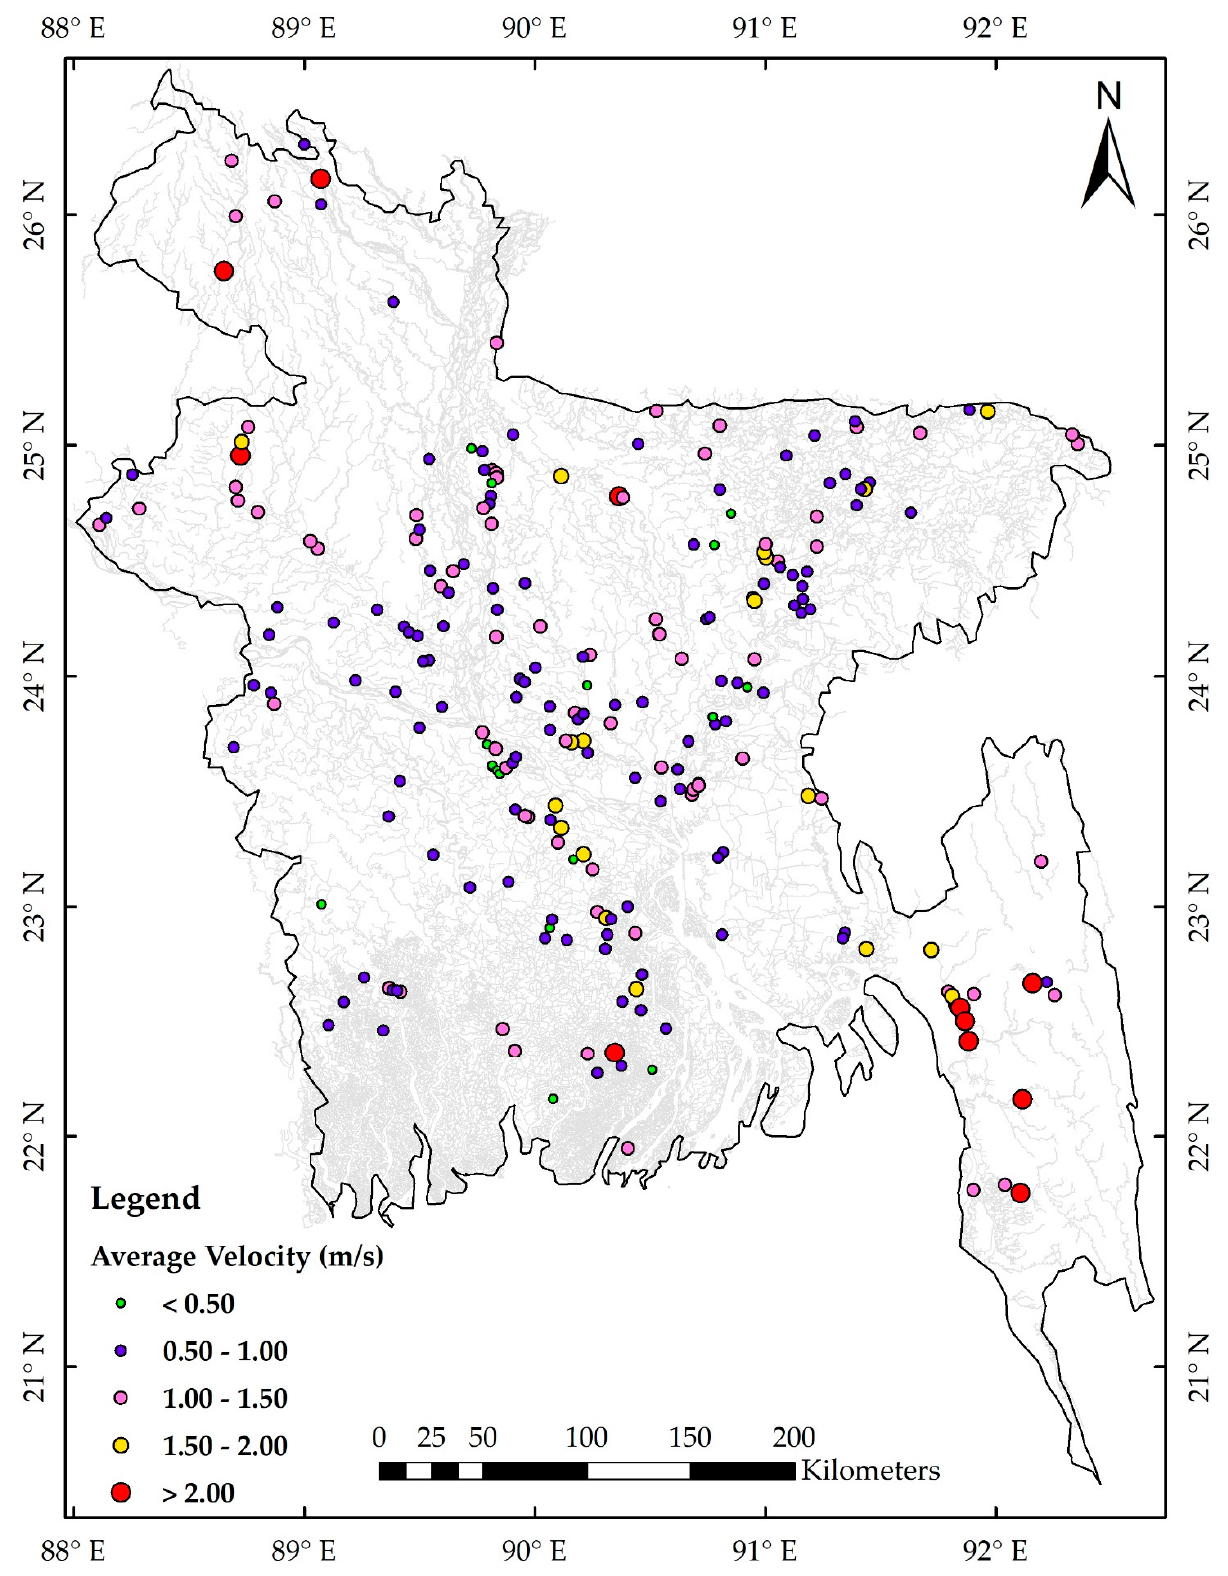
Figure 3. Variation of the average velocities in the Bangladesh rivers.